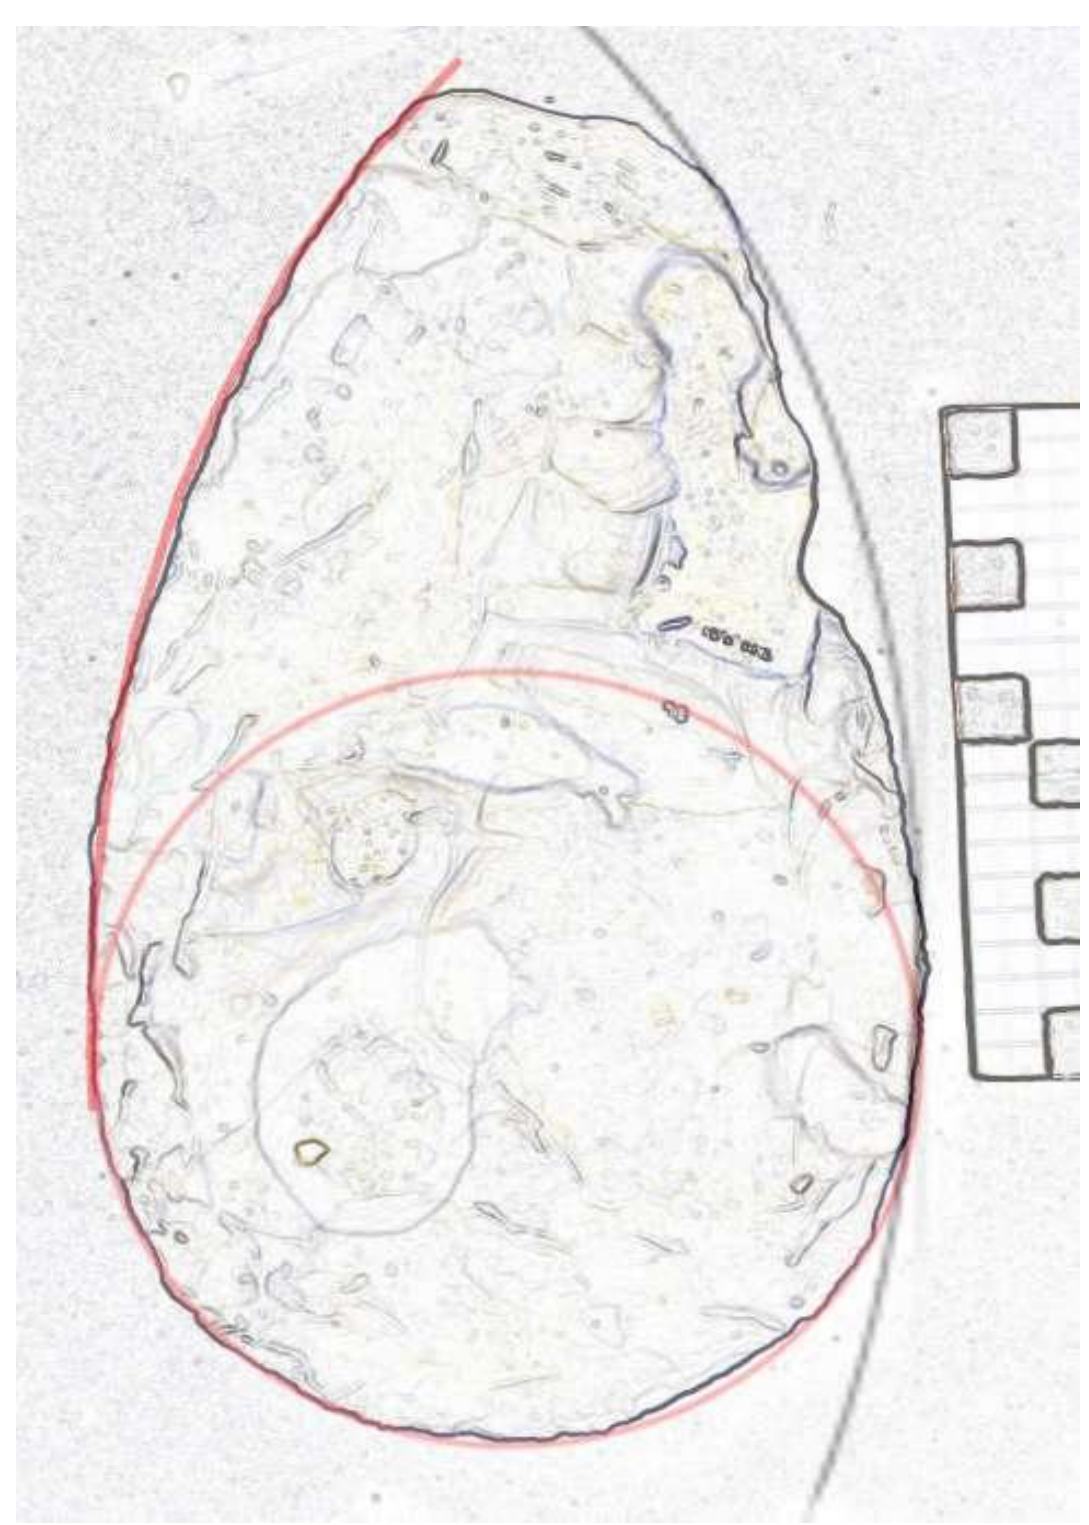
Figure 7. Specimen BD 7812